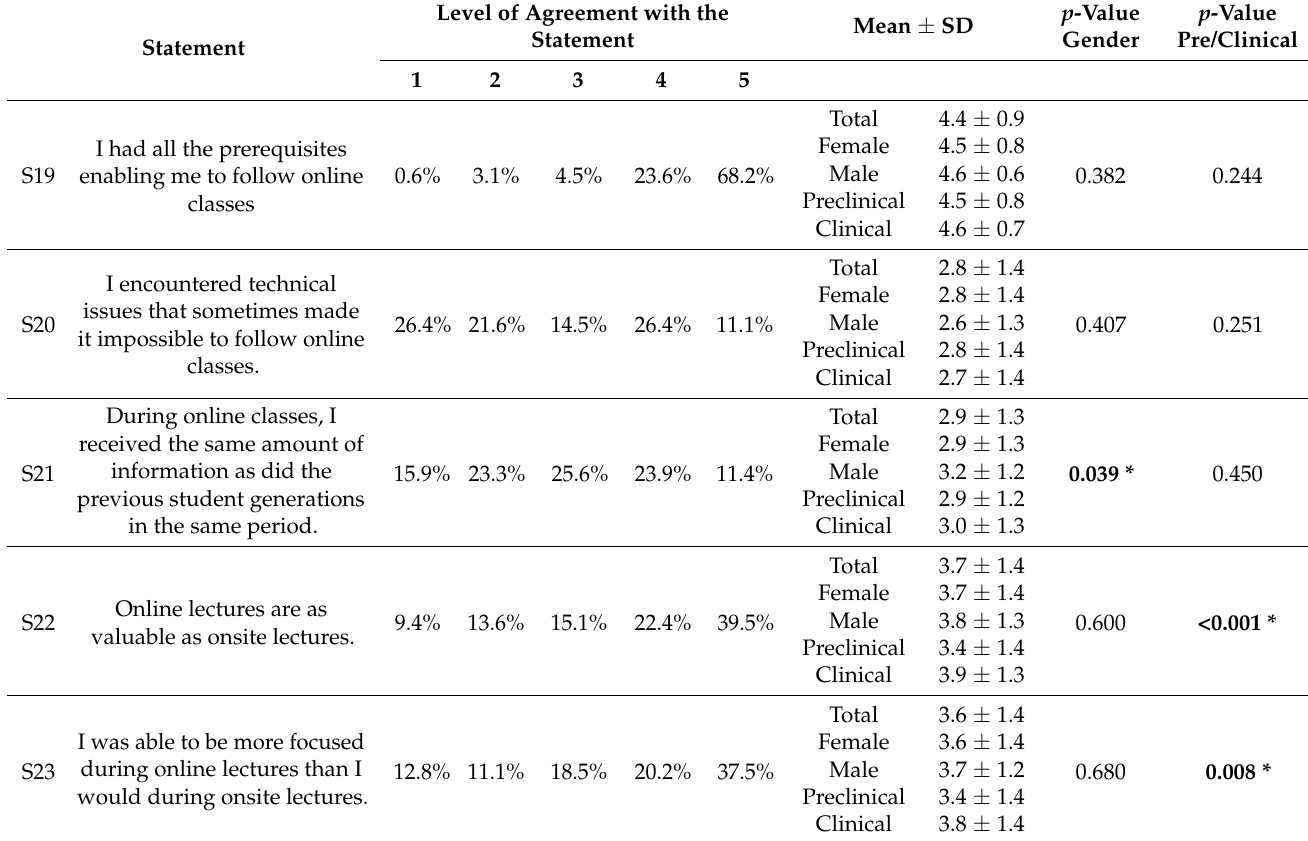
Table 4. Students’ attitudes and perception of online